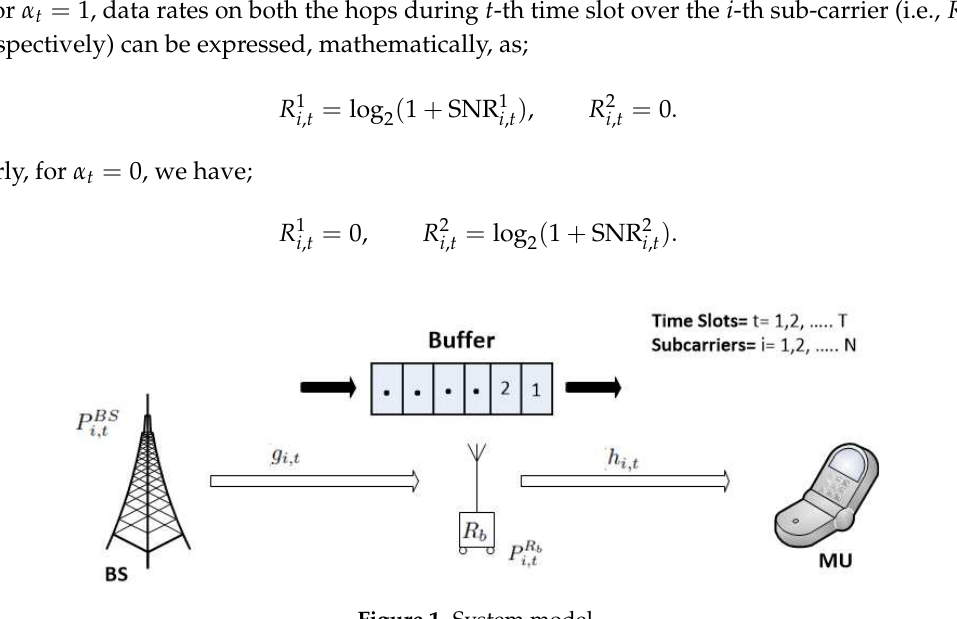
Figure 1. System